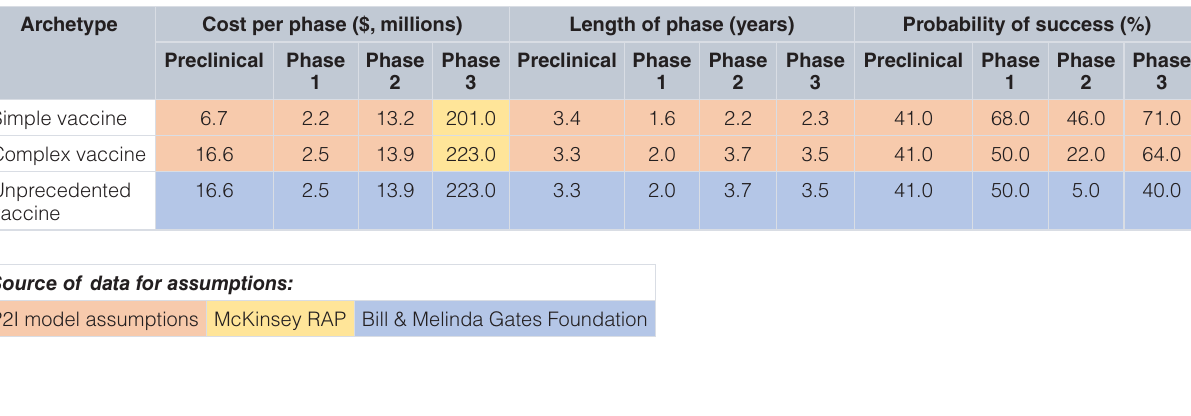
Table 4. EVI’s own data on costs, cycle times, and probabilities of success per phase (see Appendix 1 for additional details).